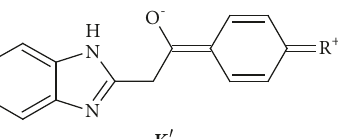
Scheme 4: Resonance structure contributing to the stabilization of the 2-phenacylbenzimidazole tautomer K by electron-donating